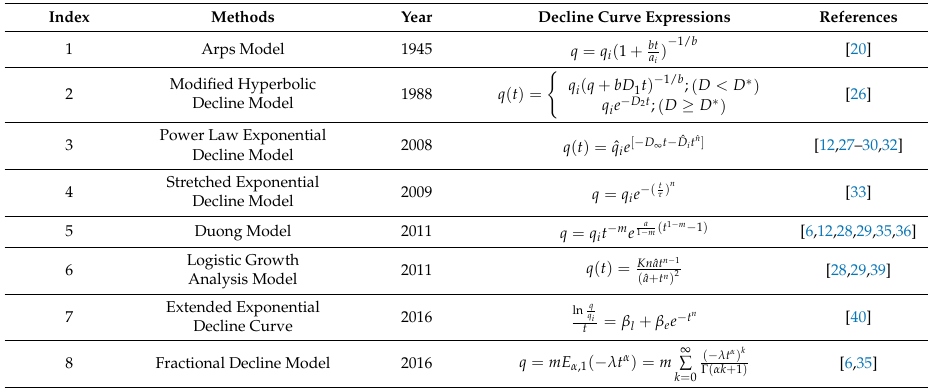
Table 1. Summary of all DCA models in this